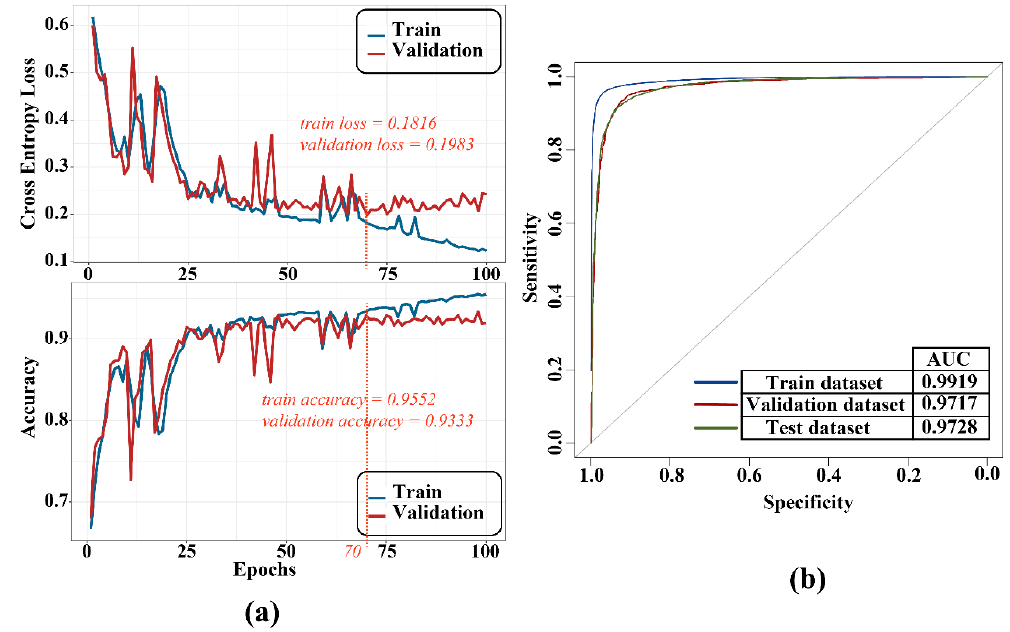
Figure 6. Training process ( a ) and ROC curve ( b ).